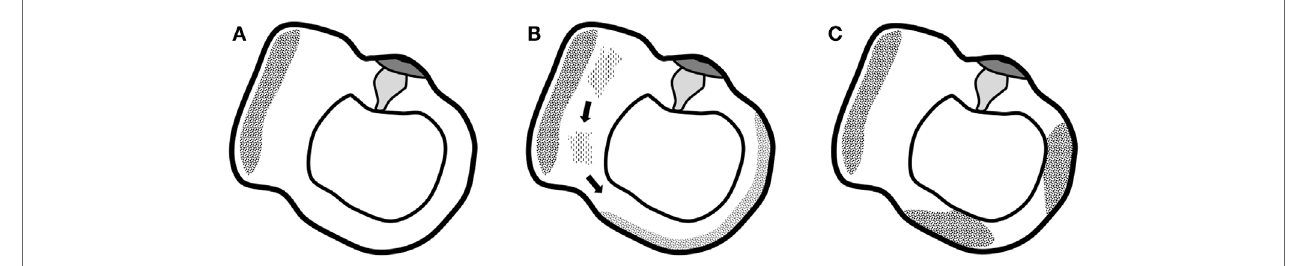
FigUre 4 | graphical representation of the suggested hypothesis . (a) Normal situation of the utricle and lateral semicircular canal with the utricle’s macula and semicircular canal’s cupula. (B) Progressive degeneration of the membranous labyrinth in the utricle might produce proteins that dislocate and accumulate in the semicircular canal. (c) Deposits eventually completely obstruct the semicircular canal and prevent the cupula from detecting angular acceleration of